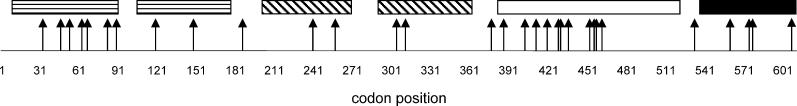
Evidence for Positive Selection on PABP3 CodonsThe rectangles correspond to the different domains of the PABP1 protein: RNA poly(A)-tail-binding domains (vertical lines), RNA-binding domains (hatched), protein–protein interaction domain (white), and PABP homo-oligomerization domain (black). Positions of positively selected codons with high posterior probabilities (>0.95) are indicated by arrows.